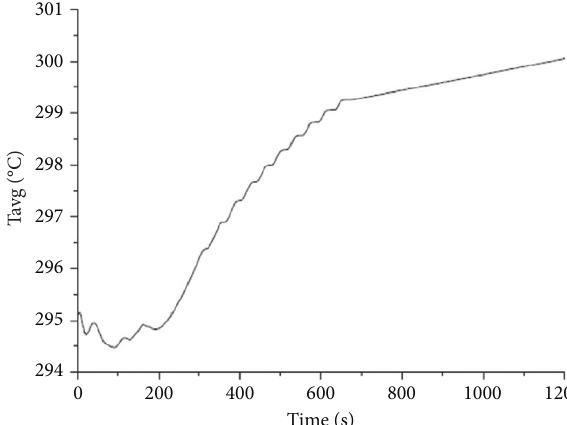
Figure 4: The average temperature change with a linear increase in the load.